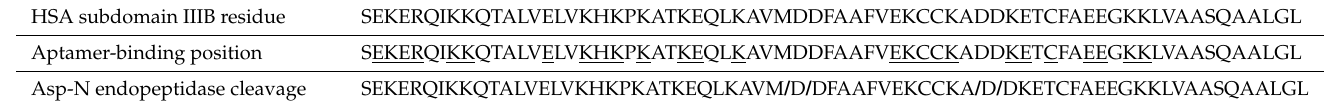
Table 1. The amino acid residues of the HSA subdomain IIIB (S517-L585), binding site of the aptamer on HSA, and the cleavage sites of the Asp-N endopeptidase (aspartyl